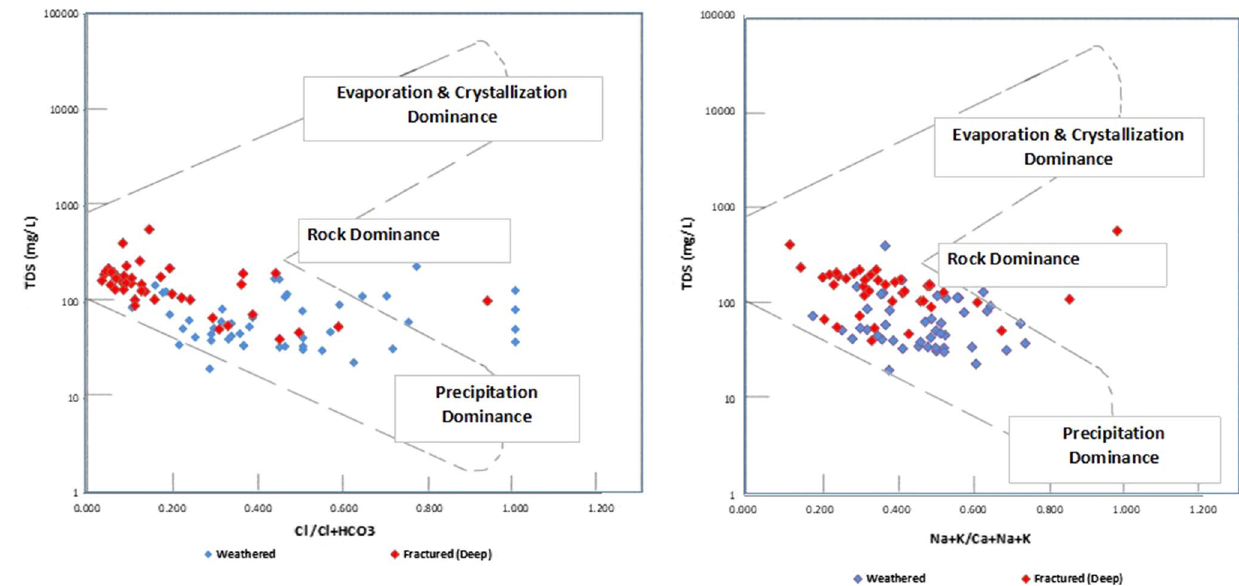
Fig. 5 Gibbs diagram showing plots of groundwater samples